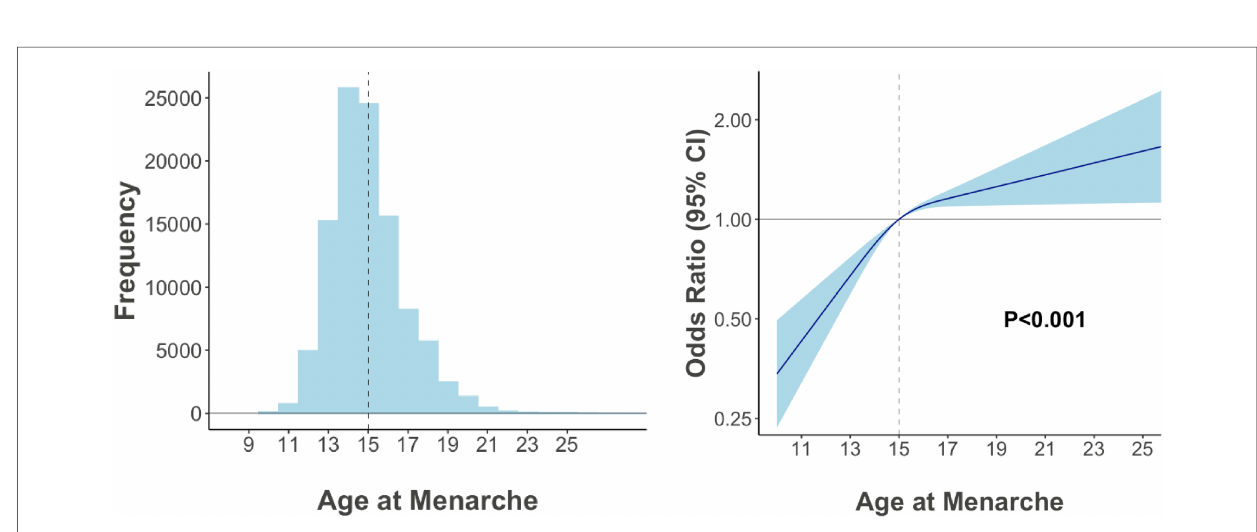
FIGURE 4 Nonlinear modeling of association between age at menarche and valvular heart disease. Age at menarche was expanded using restricted cubic